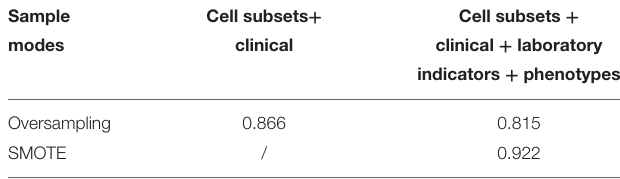
TABLE 5 | The selection of the best model.